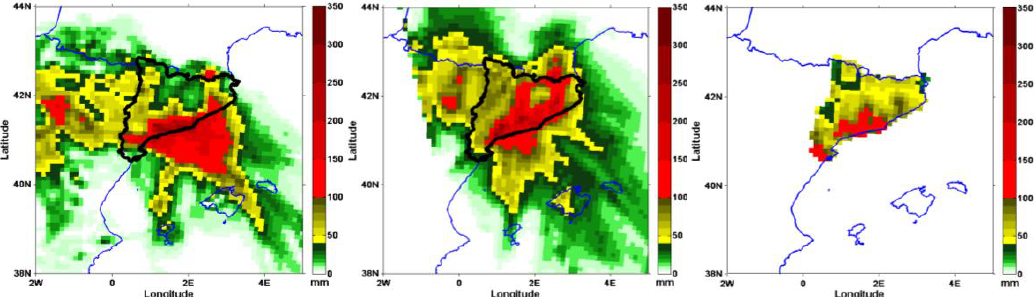
Fig. 8. MM5’s QPF (left), COSMO-I7’s (centre) and observed rainfall (right) for the whole 9–10 May 2008 event (case study 1). For clarity, the observations domain limit has been highlighted (black line) in the models’ prediction maps. Figure 8. MM5‟s QPF (left), COSMO-I7‟s (centre) and observed rainfall (right) for the 3 whole 9-10 May 2008 event (case study 1). For clarity, the observations domain limit 4 has been highlighted (black line) in the models‟ prediction maps. 5